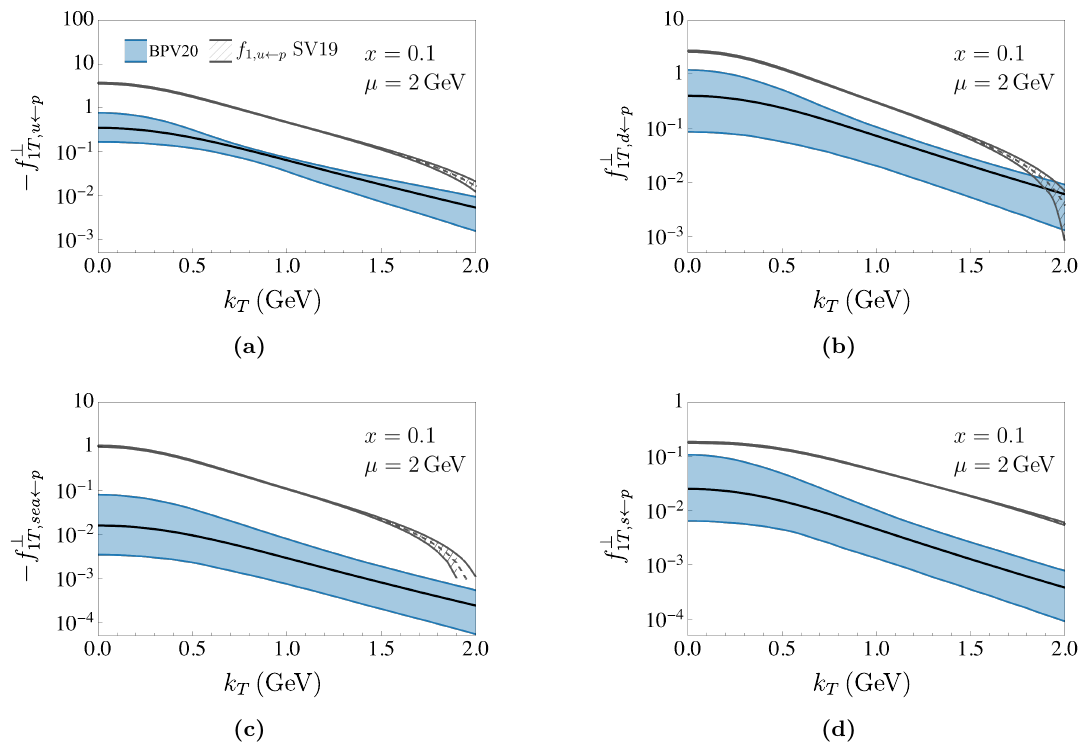
Figure 13. The ( b, x ) -landscape of the optimal Sivers function f ⊥ and u -quark (the right panel). The grid shows the CF value, whereas the shaded (blue and green) regions on the boundaries demonstrate the 68%CI.